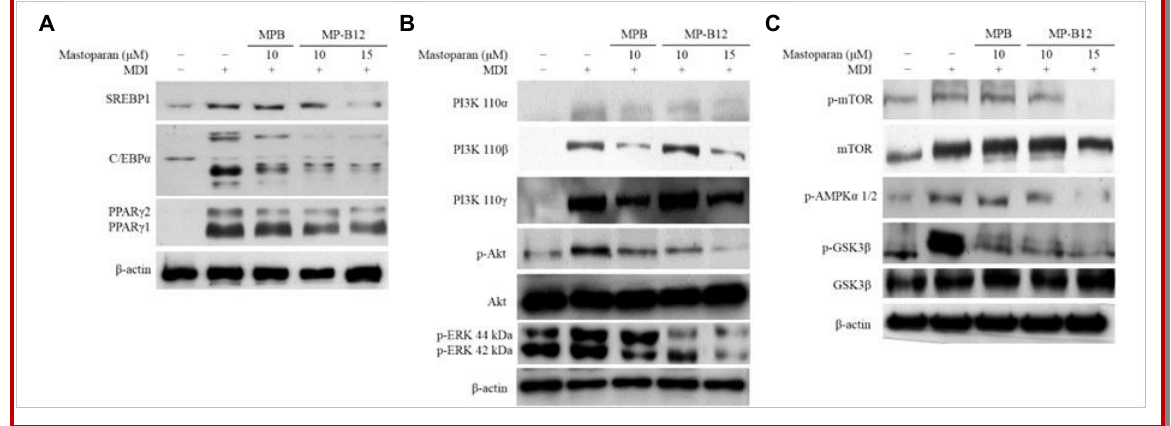
Figure 4: Effect of MP-B peptides on protein expression in 3T3-L1 cells. Differentiation of 3T3-L1 preadipocyte was induced by MDI medium in the absence or presence of MP-B peptides. The expression levels of various proteins were determined by Western blot